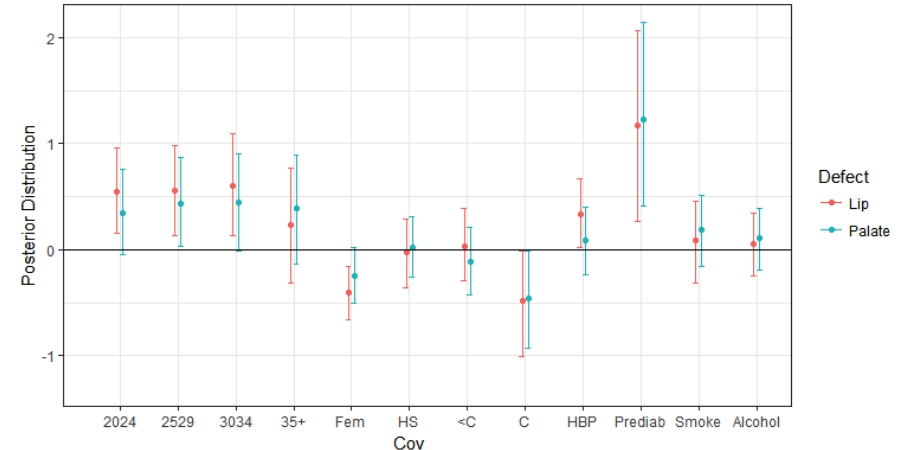
Figure 2. Covariate effects for the multivariate binary probit model. The posterior means (dots) and 95% credible intervals (lines) for a change in cleft defects with a one-standard deviation increase in maternal age, education, maternal smoking, and maternal alcohol consumption in the California National Birth Defects Prevention Study, 2003–2006. The labels from left to right are maternal age 20–24 vs. 19 and under (2024), 25–29 vs. 19 and under (2529), 30–34 vs. 19 and under (3034), 35+ vs. 19 and under (35+), fetus sex-female (Fem), maternal high school education vs. less than high school (HS), some college vs. less than high school ( < C), college graduate vs. less than high school (C), high blood pressure (HBP), maternal prediabetes (Prediab), maternal smoking (Smoke), maternal alcohol